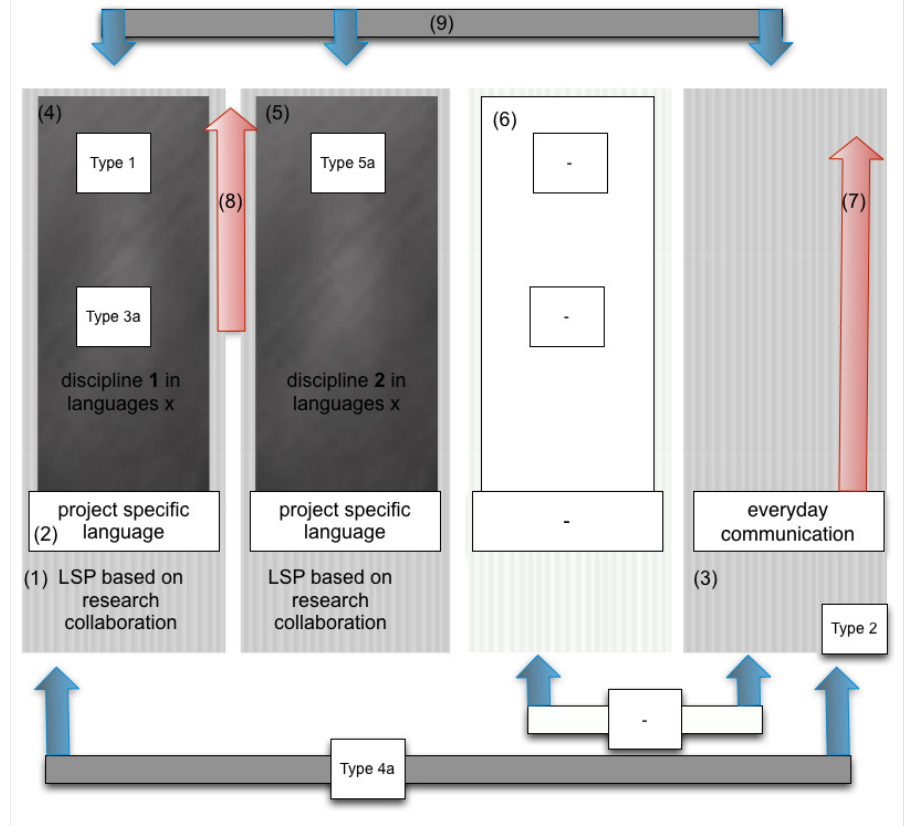
Fig. 8: interdisciplinary research project in the data collection